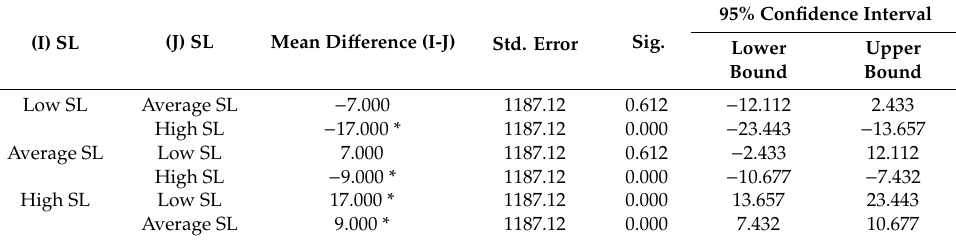
Table 4. Post-hoc test—CSE on Self-Serving Bias